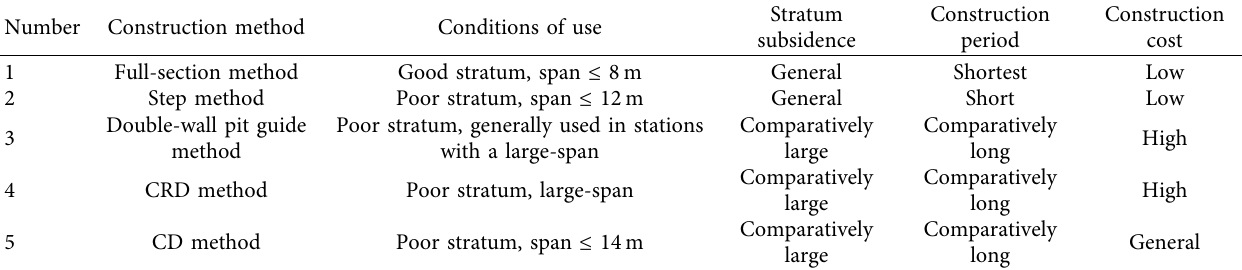
Table 2: Comparison of construction methods of shallow buried